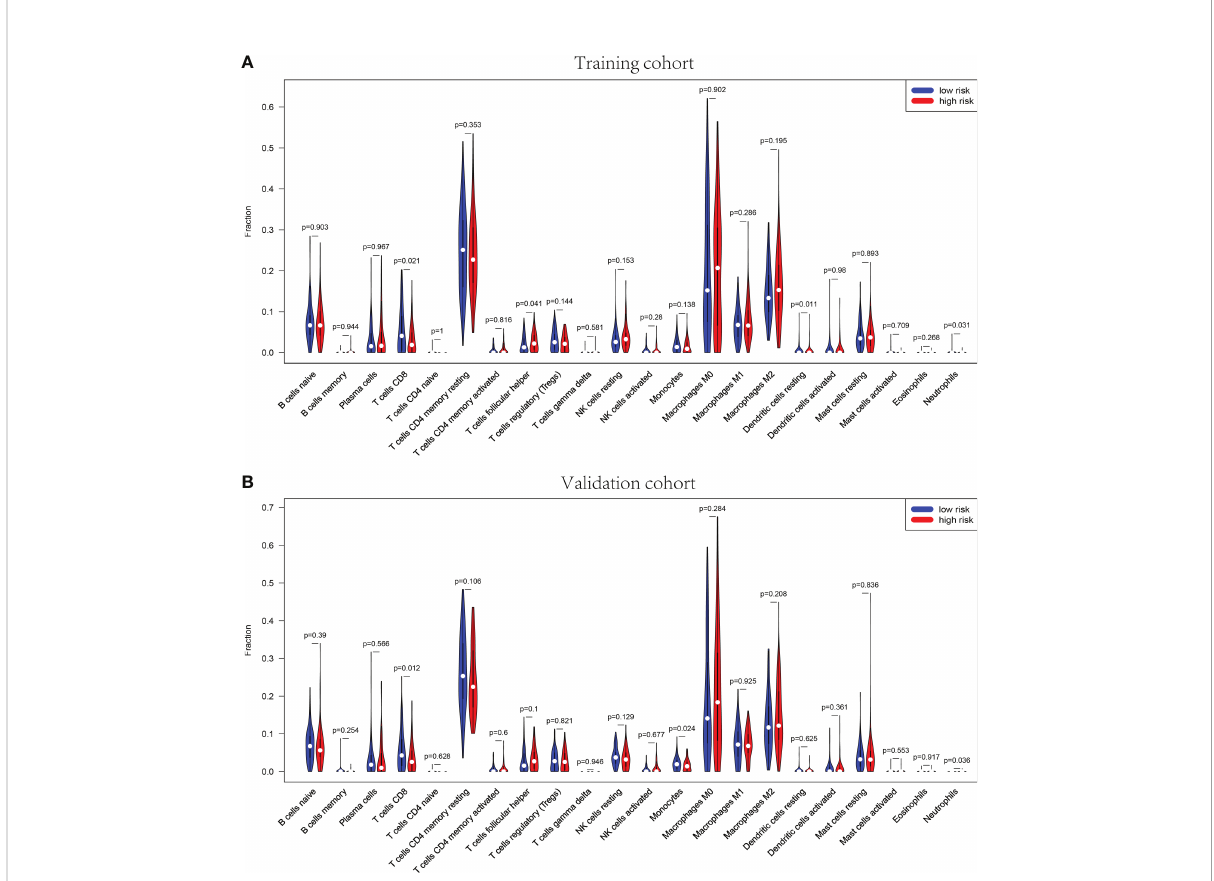
FIGURE 9 Correlation of distinct different immune cells between high- and low-risk sets in training (A) and validation (B) sets, p< 0.05. The high-risk sets are presented in red, and the low-risk sets are presented in